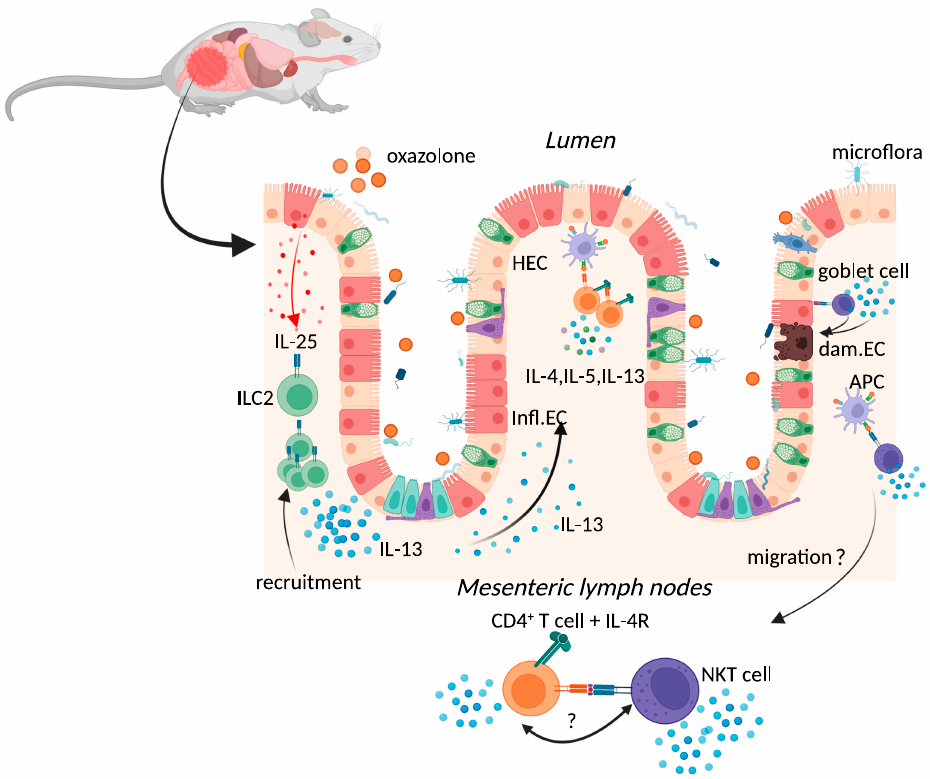
Figure 1. Immune response during oxazolone colitis. Oxazolone administration results in the production of IL-25, activation of ILC2, and production of IL-13, activating CD4+ T cell responses and amplifying type-2 cytokine production. Oxazolone administration also results in the expansion of T cells with surrogate markers of NKT cell function and IL-13 production by populations of CD1- restricted NKT cells. The resulting chronic inflammatory responses result in goblet cell depletion, increased intestinal permeability, and increased adhesion of commensal intestinal microbiota to the epithelium. Key: inflamed epithelial cells (Infl.EC), healthy epithelial cells (HEC), damaged epithelial cell (dam.EC). Created with BioRender.com, accessed on 18 August 2022.